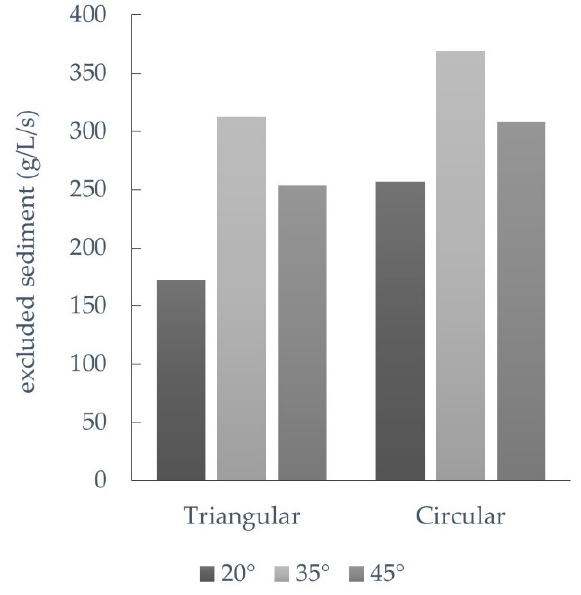
Figure 10. Graph of sediment excluded by each type of screen.